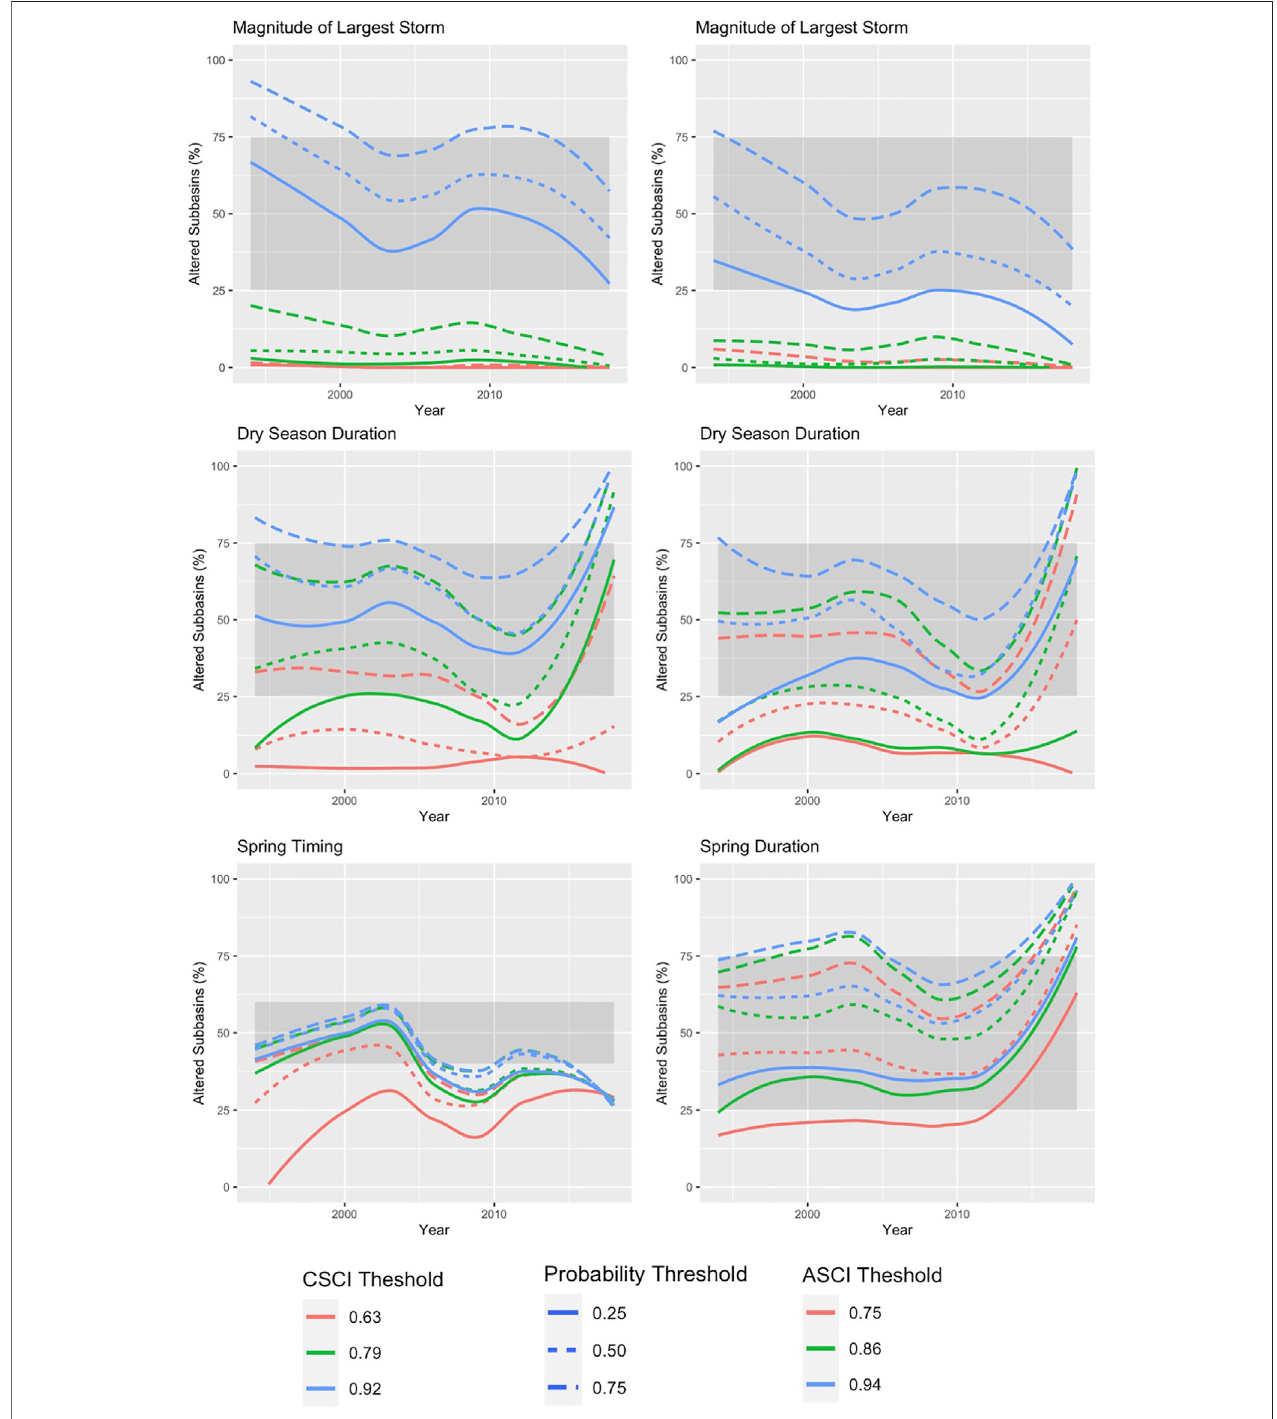
FIGURE7| Percentageofsubbasinsclassi fi edasalteredeachyearforthemodelledperiodofrecord(1994 – 2018)undereachthresholdcombinationforCSCI(left panel)andASCI(rightpanel).Thegreyboxindicatestherangeofalteredsubbasins(%)neededtoprovidediscriminatorypower.Thethresholdcombinationlinesmustbe within the grey box throughout the time series to remain in the analysis.